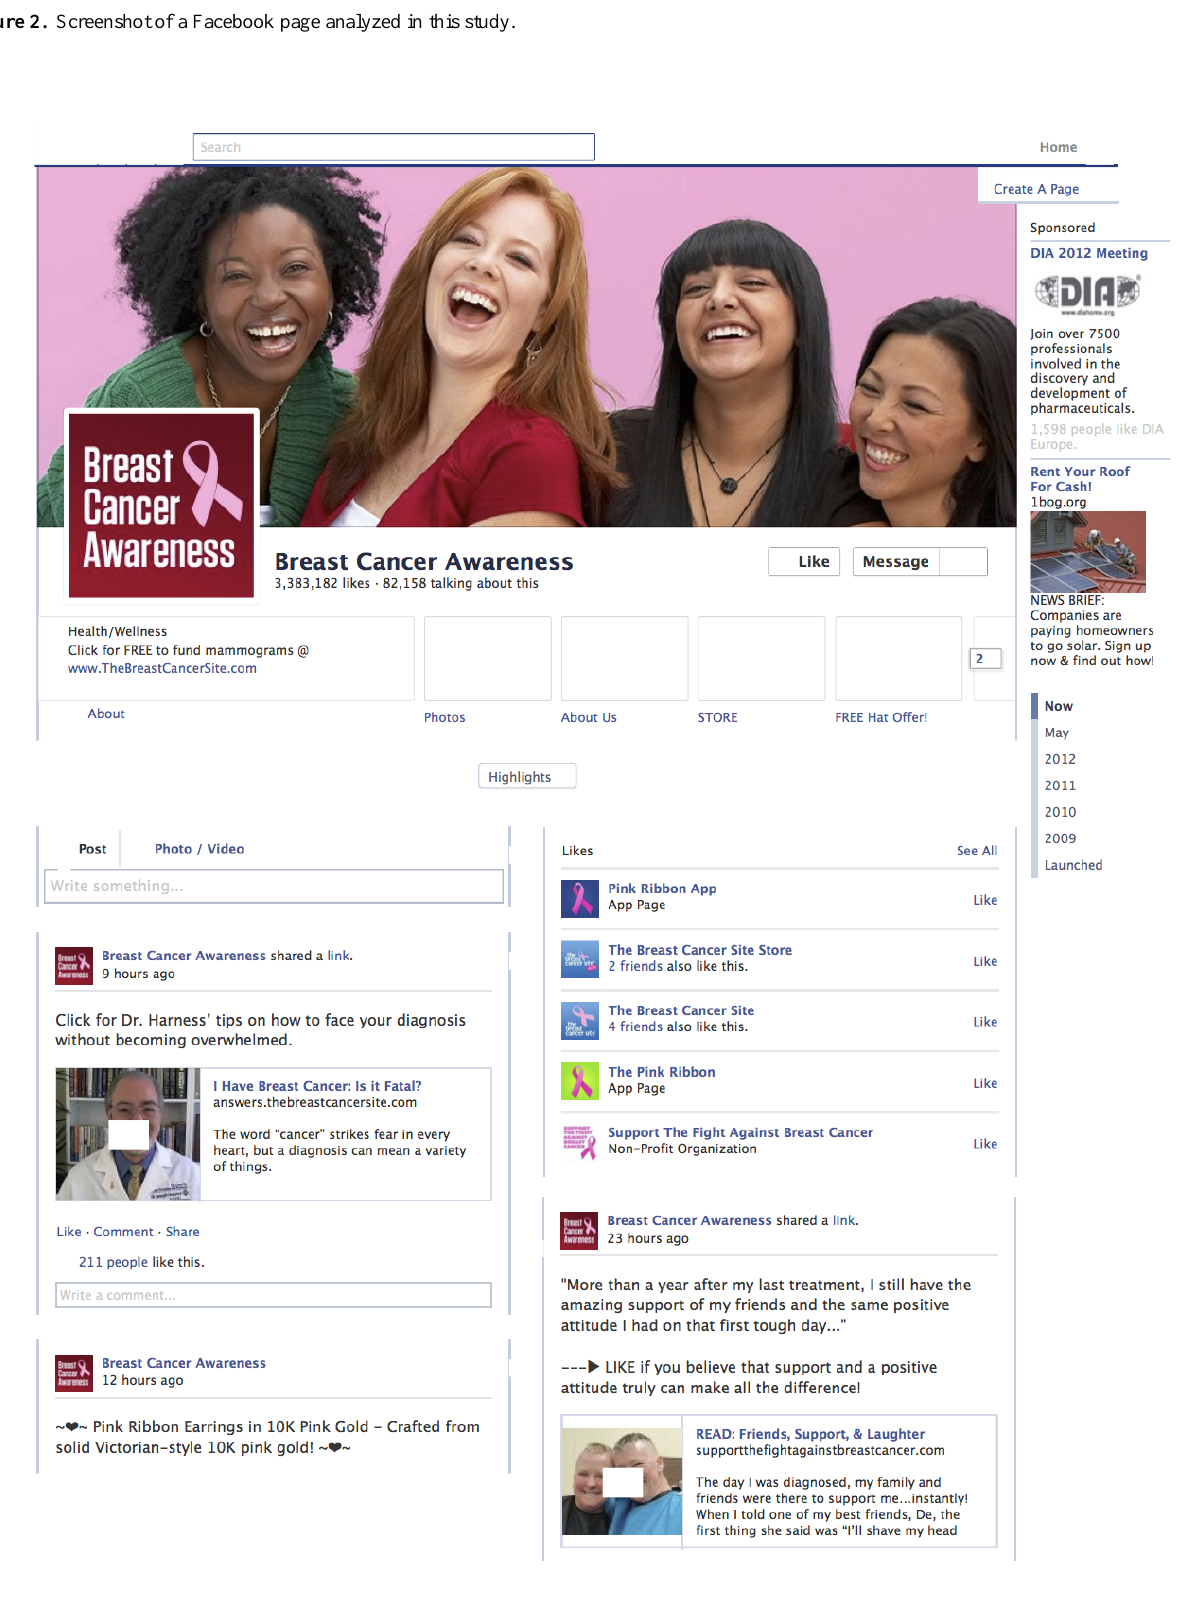
Figure 2. Screenshot of a Facebook page analyzed in this